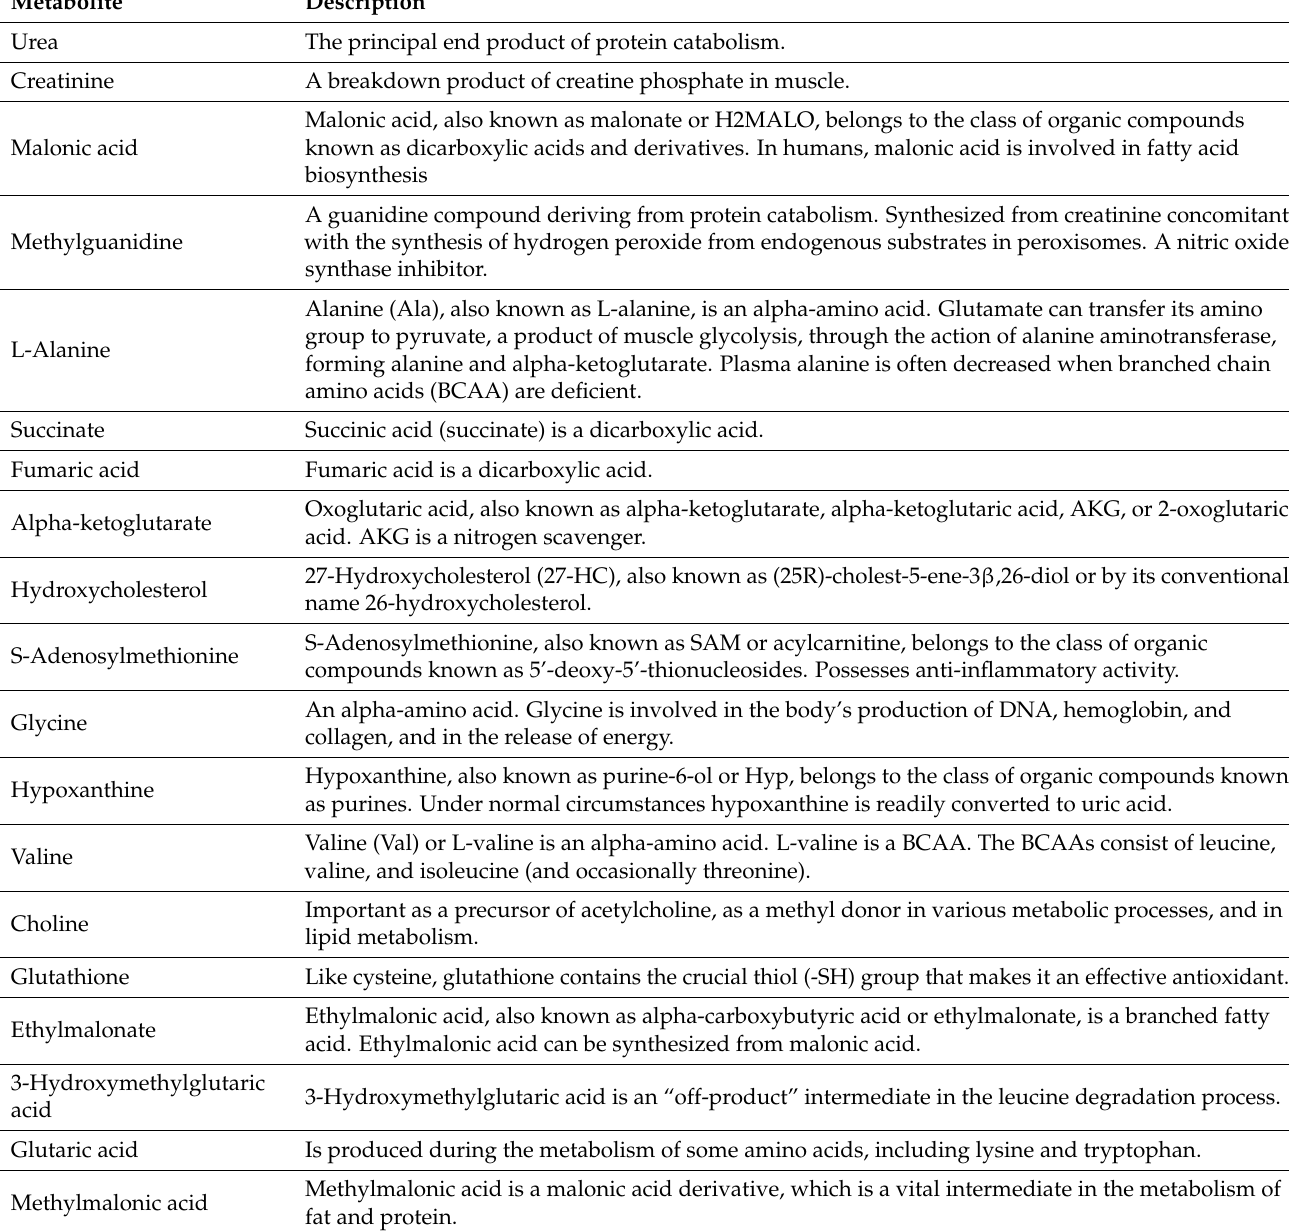
Table 2. Metabolites related to oxidative stress [29–32]. Reproduced with permission from Dr. Wishart, University of Alberta, Edmonton,